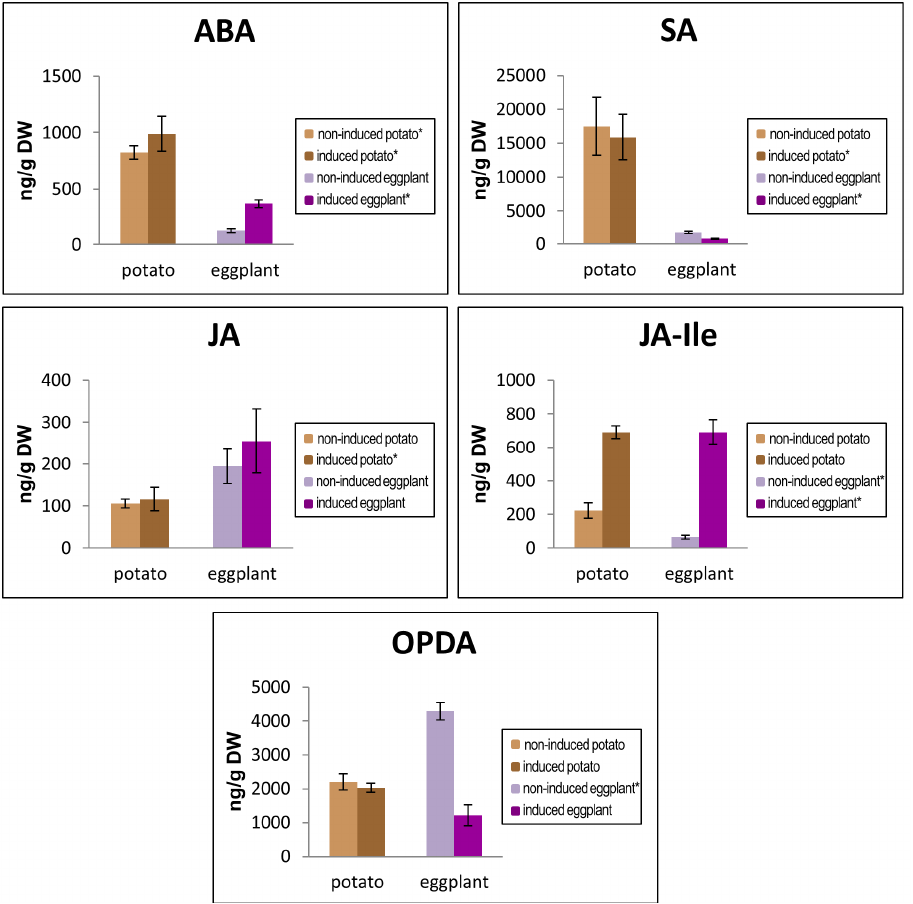
acid (ABA), salicylic acid (SA), jasmonic acid (JA), jasmonoyl- L -isoleucine (JA-Ile) and 12-oxo-phytodienoic acid (OPDA) levels were determined in lyophilized material by high performance liquid chromatography mass spectrometry. Data are the mean ± standard error of two ( n = 2), or three experiments ( n = 3) in determinations labeled with an asterisk in